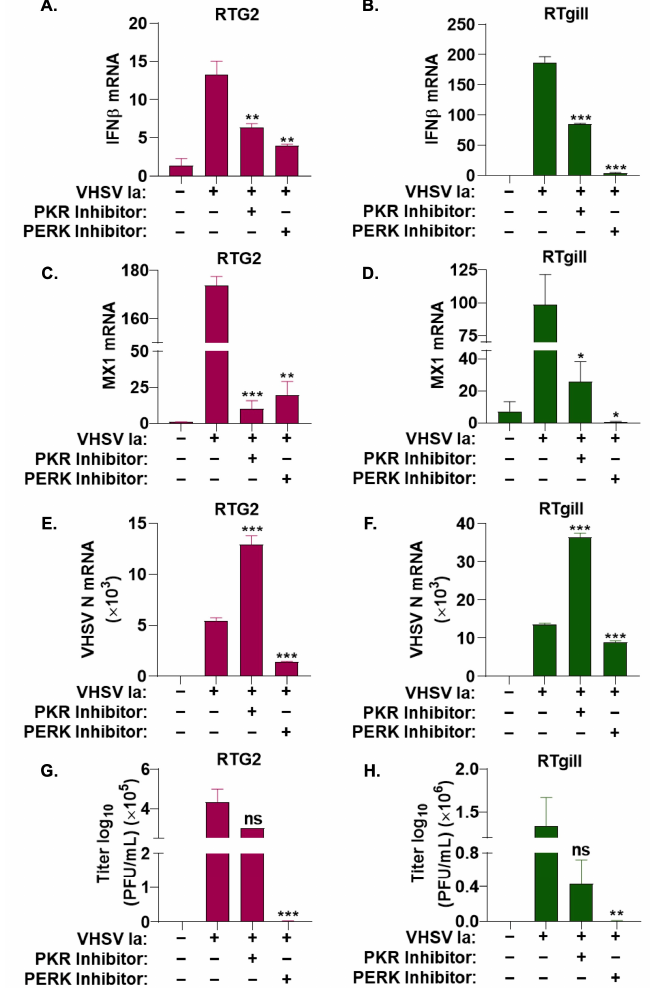
Figure 4. Role of ISR pathways on IFN signaling during VHSV infection. RTG2 ( A , C , E , G ) and RTgill ( B , D , F , H ) cells were treated with PERK inhibitor or PKR inhibitor 1 h prior to infection with VHSV Ia for 36 h and mRNA levels of ( A , B ) IFN β , ( C , D ) MX1, or ( E , F ) VHSV N determined by RT-PCR. Data was normalized to spiked internal control and presented as fold change in expression compared to no treatment. ( G , H ) VHSV Ia titers were determined in supernatants of infected cells by plaque assays. Error bars reflect SEM. ns, not significant; *, p < 0.05; **, p < 0.01; ***, p < 0.001, ns = “not significant”.